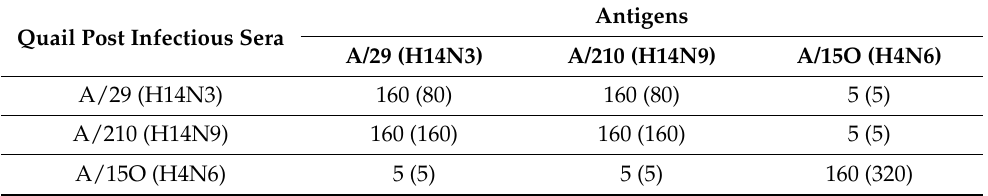
Table 3. Antigenic analysis of influenza A/H14 viruses (HI (VN) titers). Quail Post Infectious